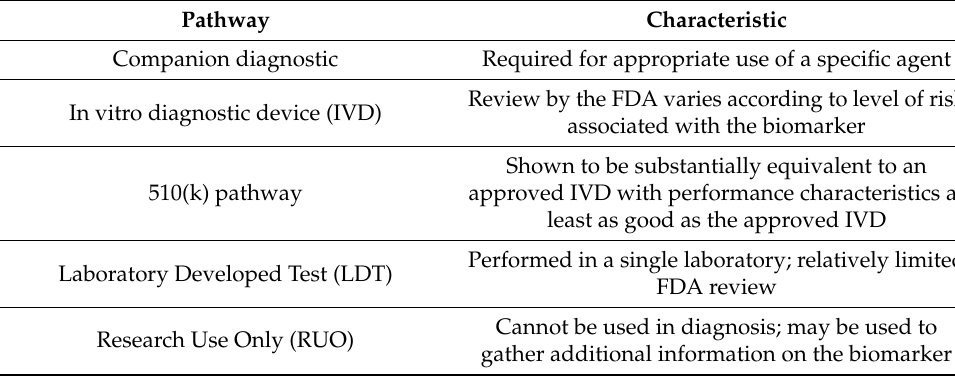
Table 4. Pathways of biomarkers to progress to clinical use.